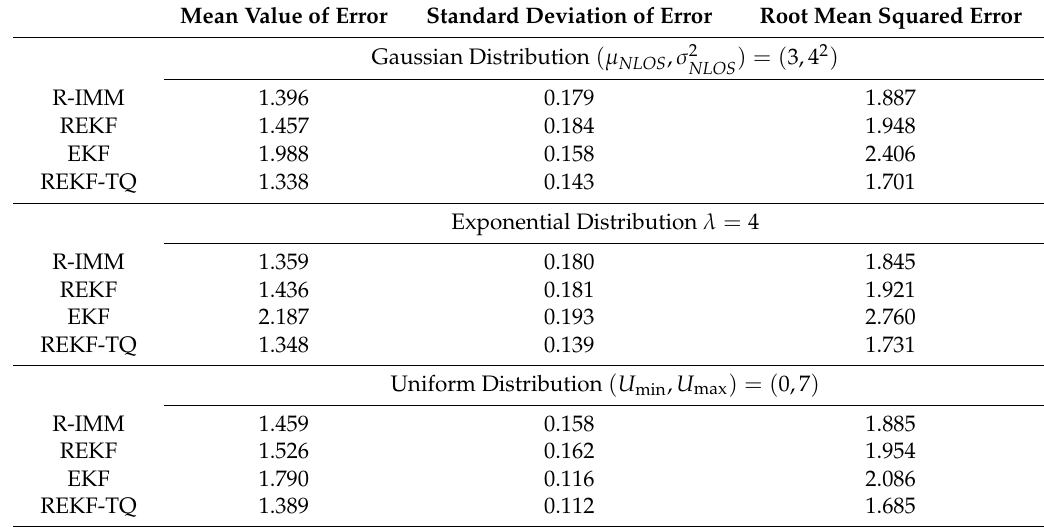
Table 4. The mean value of error, standard deviation of error, root mean squared error (in m) of estimators for Gaussian, exponential and uniform NLOS